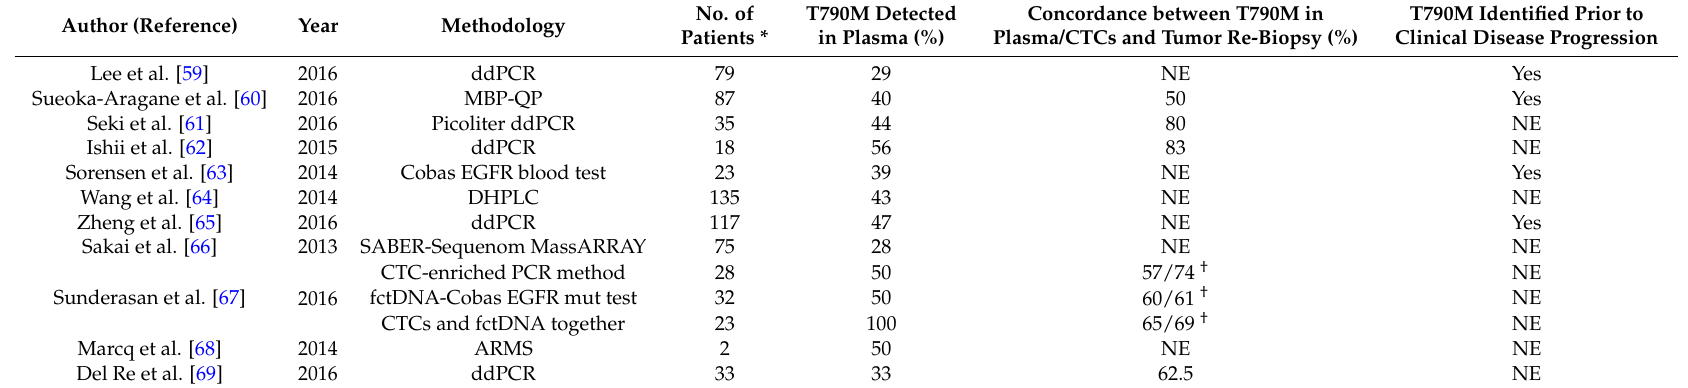
Table 1. Literature data on T790M identification in free circulating tumor DNA (fctDNA) during tyrosine kinase inhibitors (TKI)